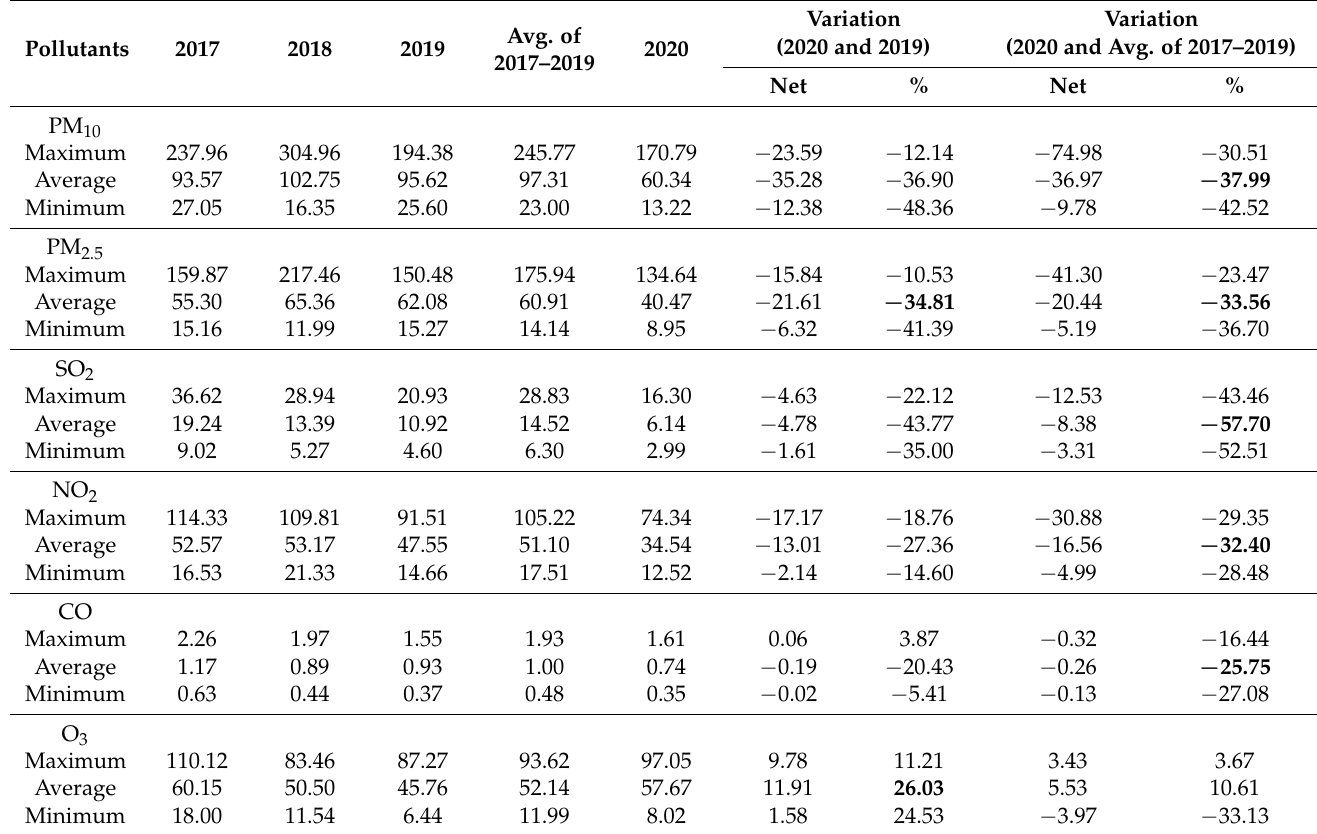
Table 2. 24 h average concentration and variation of pollutants during 2017–2020 (same dates of lockdown) in Nanjing. (Bold values show average maximum decrease).